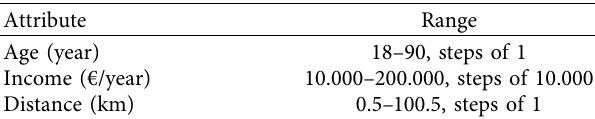
Table 1: Synthetic dataset person and trip attributes.